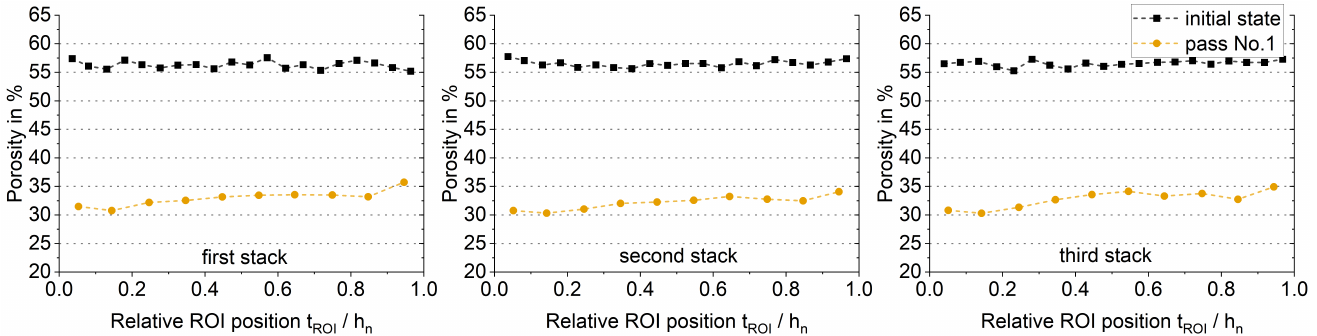
Figure 10. Series I: 20-0.50-1 ( l d / h m ≈ 2.1): Porosity change over relative sample depth (0=upper surface; 0.5= mid-section of sample; 1 =lower surface) due to rolling for first, second and third